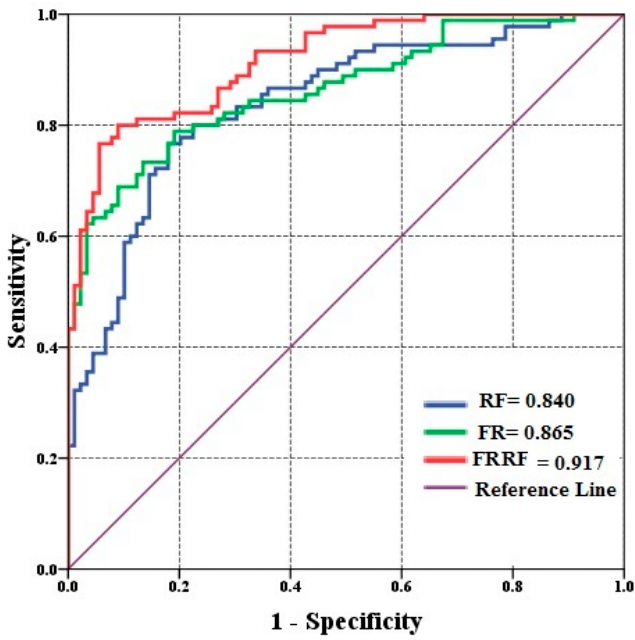
Figure 7. Area under curve ( AUC) values of FR, RF and integrated model. Remote Sens. 2019 , 11 , 999